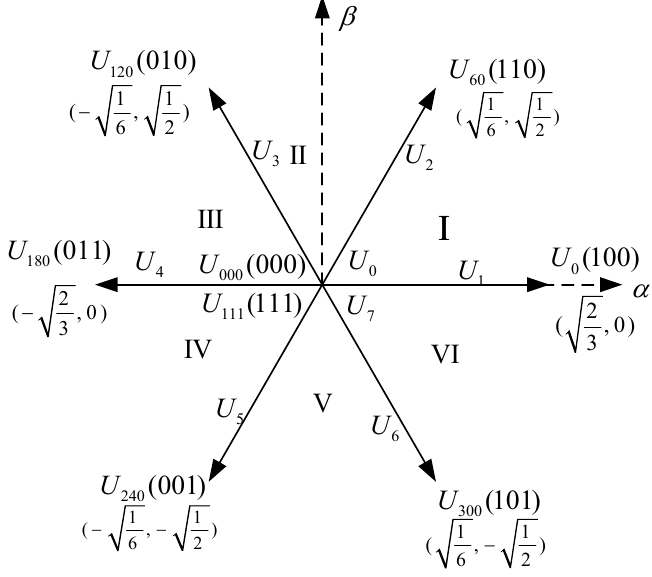
Figure 8. Eight switch states for the three ‐ phase inverter.